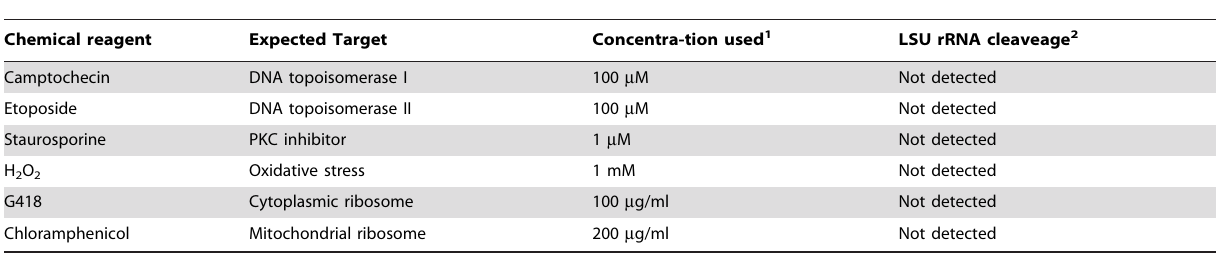
Table 2. Chemical-induced stress and mitochondrial rRNA integrity.